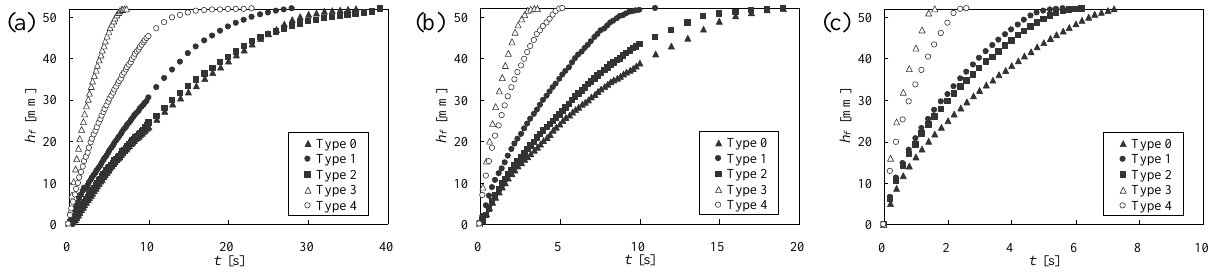
Fig. 5 Advancement of air-liquid interface h in cases of (a) H =100 mm, (b) H =200 mm, and (c) H =300 mm. The order of f wettability, Type 3, 4, 1, 2, and 0, is constant for these H